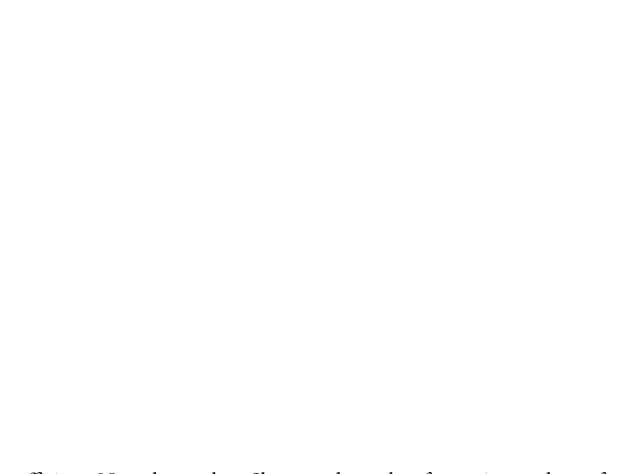
Table 4. Variation of local skin friction coefficient, Nusselt number, Sherwood number for various values of So for n = 1, 2, 3.